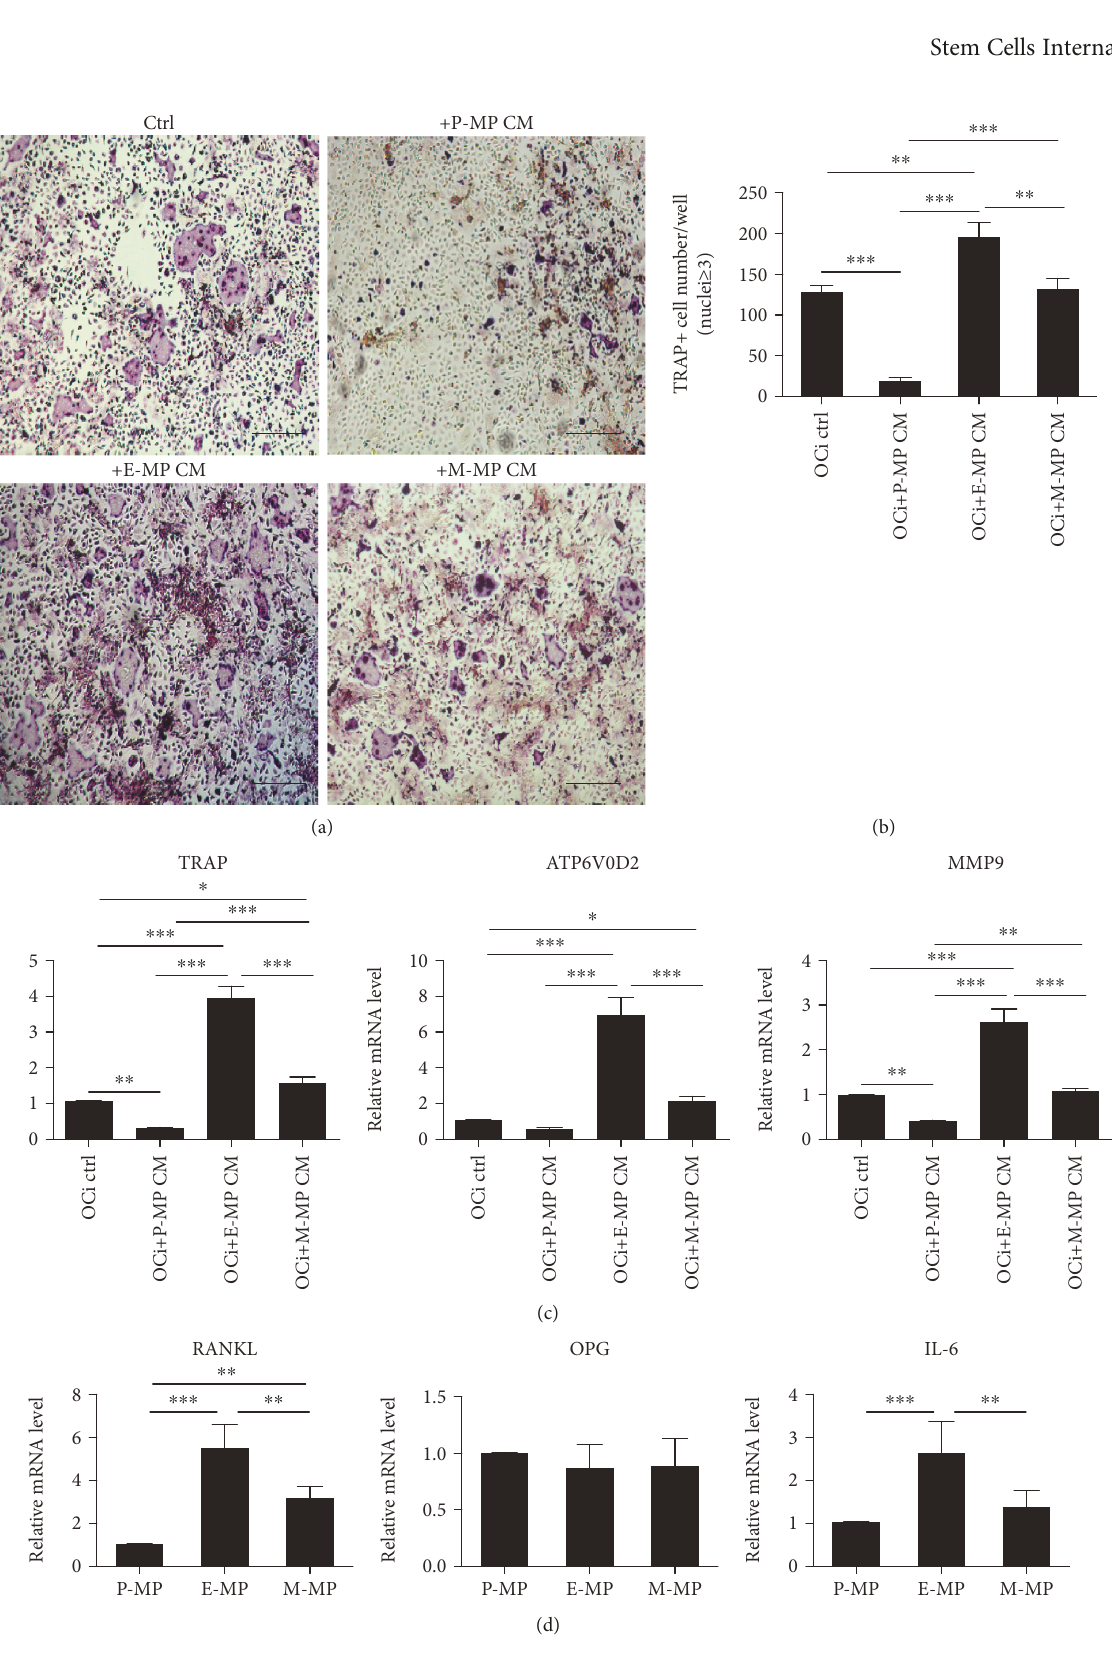
Figure 4: Conditioned medium from E-MPs promoted osteoclast formation. (a) TRAP staining was used to detect osteoclast formation from osteoclast precursors, after culturing in osteoclastic di ff erentiation medium with CM from di ff erent MPs for 7 days. Scale bar, 200 μ m. OCi: osteoclast induction. (b) TRAP-positive cells ( nuclei ≥ 3 ) were counted. (c) The mRNA levels of osteoclast marker genes were detected by qRT-PCR. (d) The expression of several paracrine genes which were related to osteoclast formation was evaluated in the three MP groups. Data was shown as mean ± SD . ∗ p < 0 05 ; ∗∗ p < 0 01 ; ∗∗∗ p < 0 001